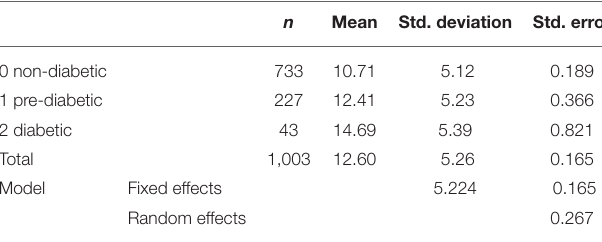
TABLE 2 | Mean difference in total GHQ-12 score across diabetic class categories. n Mean Std. deviation Std.